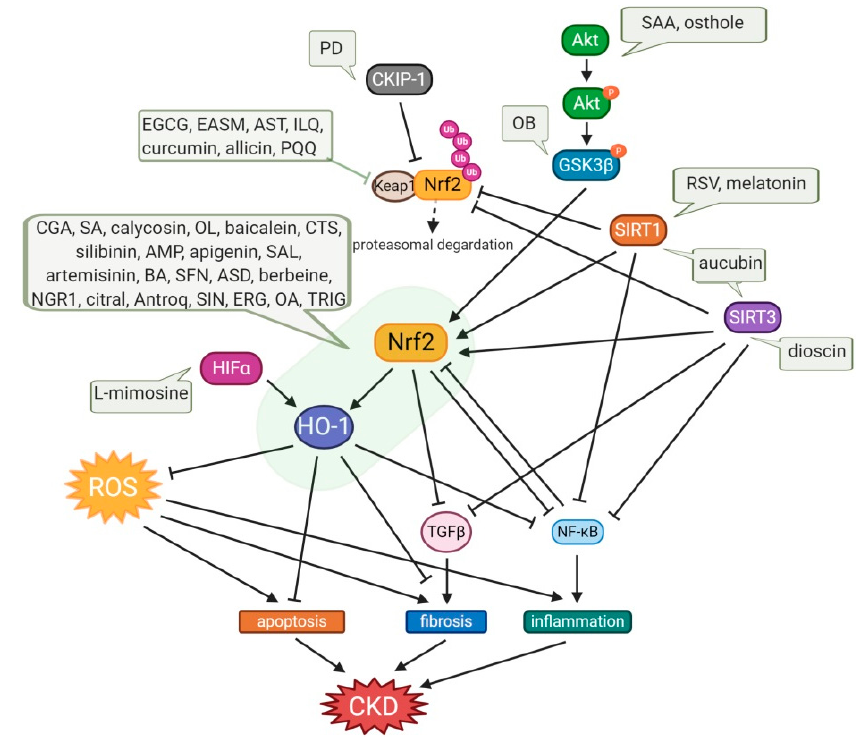
Figure 3. Protective effects of small-molecule natural products on OS in CKD. Osthole and SAA enhance the activation of the Akt/Nrf2/HO-1 signaling pathway with suppression of NF-kB and TGF β 1, consequently attenuating OS, inflammation, and fibrosis. OB induces the phosphorylation of GSK3 β , which inhibits Fyn-mediated Nrf2 nuclear export, and activates the transcription of Nrf2-driven antioxidant genes. Expression of SIRT1, which inhibits NF-kB activity, and the activation of Nrf2 are enhanced by aucubin, melatonin, and RSV, which also upregulates SIRT3, resulting in amelioration of kidney injury. Dioscin upregulates SIRT3 level, promotes Nrf2, and suppresses Keap1 expression, resulting in inhibition of inflammation, lipid metabolism, OS, and kidney fibrosis. PD increases the CKIP-1 expression level and promotes the interaction of CKIP-1 with Nrf2, conse- quently activating the Nrf2-ARE antioxidative pathway. Allicin, AST, curcumin, EASM, EGCG, ILQ, and PQQ attenuate OS via the Nrf2/HO-1 signaling pathway with inhibition of Keap1, and they also reduce TGF β -mediated fibrosis and NF-kB-induced inflammation. In the cases of an anti- fibrotic effect of apigenin, ASD, baicalein, BA, CGA, CTS, ERG, OL, and SFN, AMP, antroq, arte- misinin, berbeine, calycosin, SA, SIN, and TRIG, they are mediated not only by upregulation of the Nrf2/HO-1 antioxidant signaling pathway and downregulation of NF-kB-induced inflammation, but also via TGF β suppression. Treatments with citral, NGR1, OA, SAL, and silibinin have potency for anti-apoptotic effects with regulation of Bcl2/Bax and caspase3. The decrease in the NLRP3 in- flammasome was also observed in treatments with baicalein, EGCG, and OL. L-mimosine activates HIF1 α , which upregulates renoprotective HIF target genes, such as VEGF, HO-1, and GLUT1, and decreases fibrosis markers. AMP, ampelopsin; Antroq, antroquinonol; ASD, akebia saponin D; AST, astaxanthin; BA, betulinic acid; CGA, chlorogenic acid; CTS, cryptotanshinone; EASM, ethyl acetate extract of Salvia miltiorrhiza; EGCG, Epigallocatechin gallate; ERG, ergone; GSK3 β , glycogen syn- thase kinase 3 β ; HIF α , hypoxia-inducible factor α ; ILQ, isoliquiritin; NGR1, notoginsenoside R1; OA, oleanolic acid; OB, obacunone; OL, oleuropein; PD, polydatin; PQQ, pyrroloquinoline quinone; RSV, resveratrol; SA, sinapic acid; SAA, salvianolic acid A; SAL, salidroside; SFN, sulforaphane; SIN, sinomenine; TRIG, trigonelline.